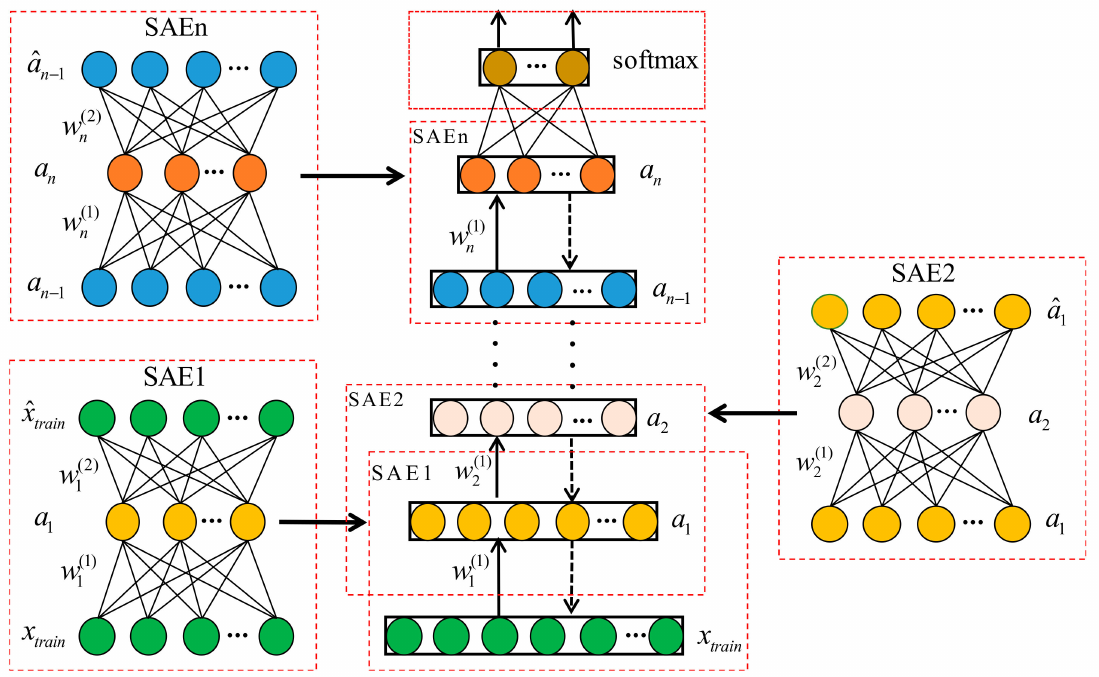
Figure 1. AE structure and the training process of